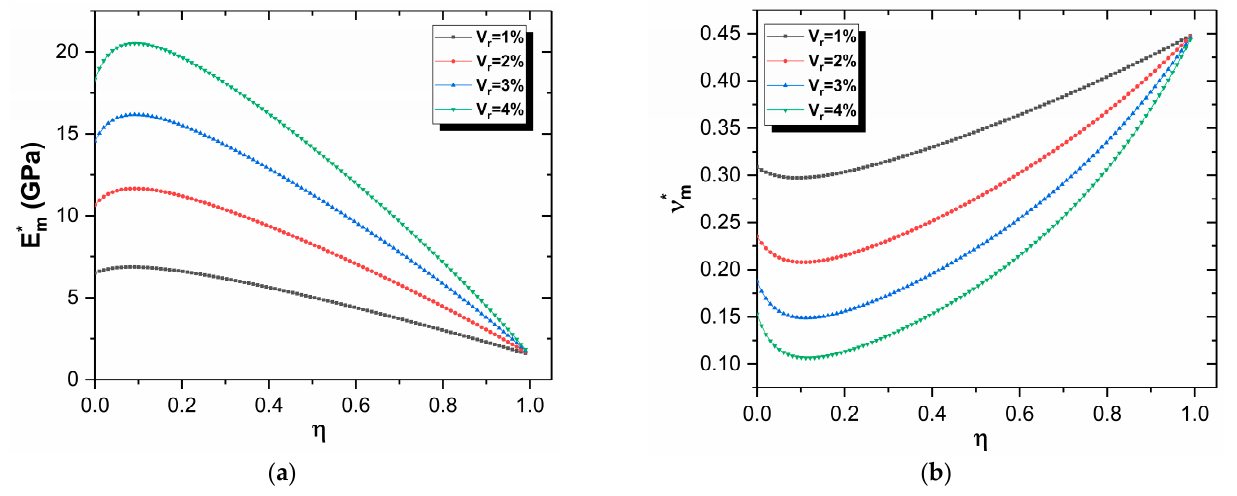
Figure 17 . Effective elastic moduli of composite reinforced by randomly GNP inclusion in PP matrix, in function of η for µ = 0.2 with a maximum of Young’s modulus E ∗ m and minimum of Poisson’s ratio ν ∗ m : ( a ) effective Young’s modulus E ∗ m ; and ( b ) effective Poisson’s ratio ν ∗ m